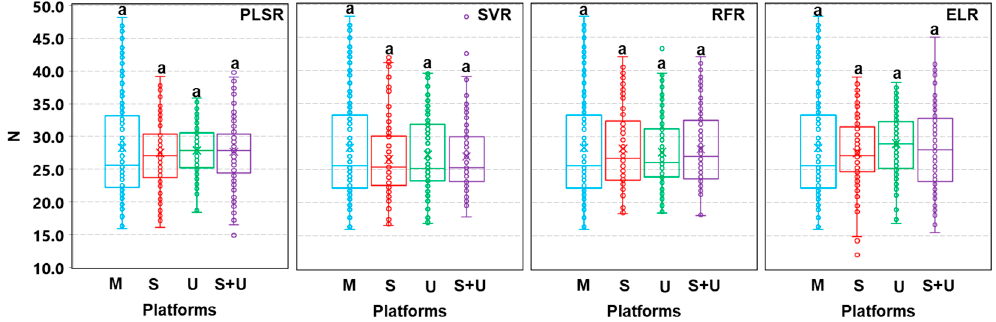
Figure 7. Boxplot for measured (M) and predicted N using satellite (S), UAV (U), as well as combined satellite and UAV (S + U), data from each model. ANOVA was carried out, and the letter ‘a’ on the bars indicate no significant differences according to the HSD Tukey's test ( α = 0.05).